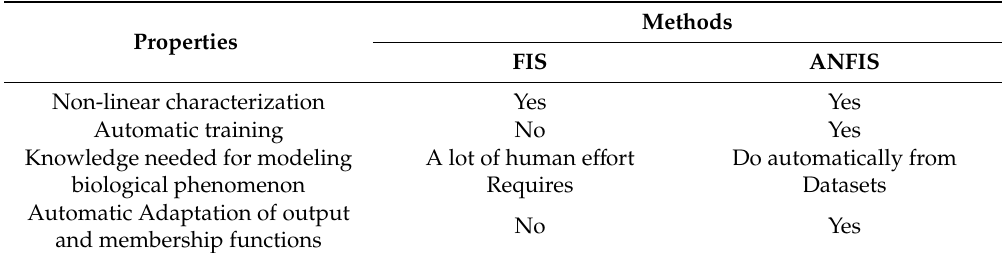
Table 9. Comparison of two related technologies FIS and ANFIS.